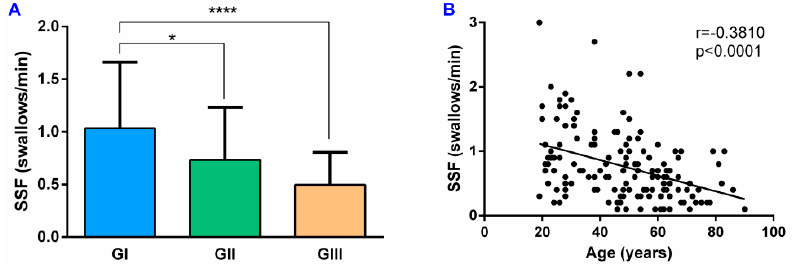
Figure 2. SSF and its correlation with age in HV: ( A ) SSF results by age groups; ( B ) correlation between SSF and age. SSF: spontaneous swallowing frequency; GI: 18–39 years age group; GII: 40– 59 years age group; GIII: ≥ 60 years age group; * p < 0.05; **** p < 0.0001.